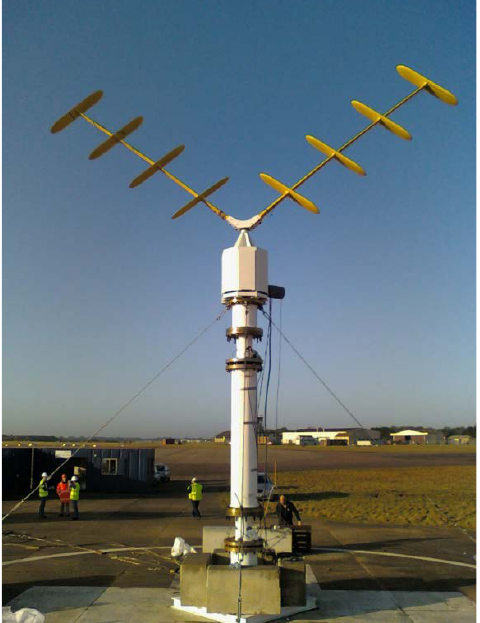
Figure 1. Prototype of original NOVA V-VAWT